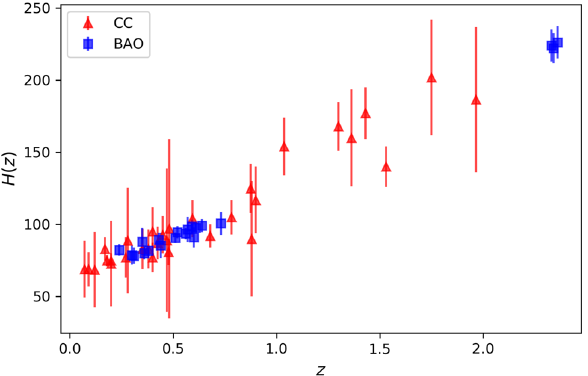
Fig. 1 The real CC and BAO data serving as the basis for mock reali- sations